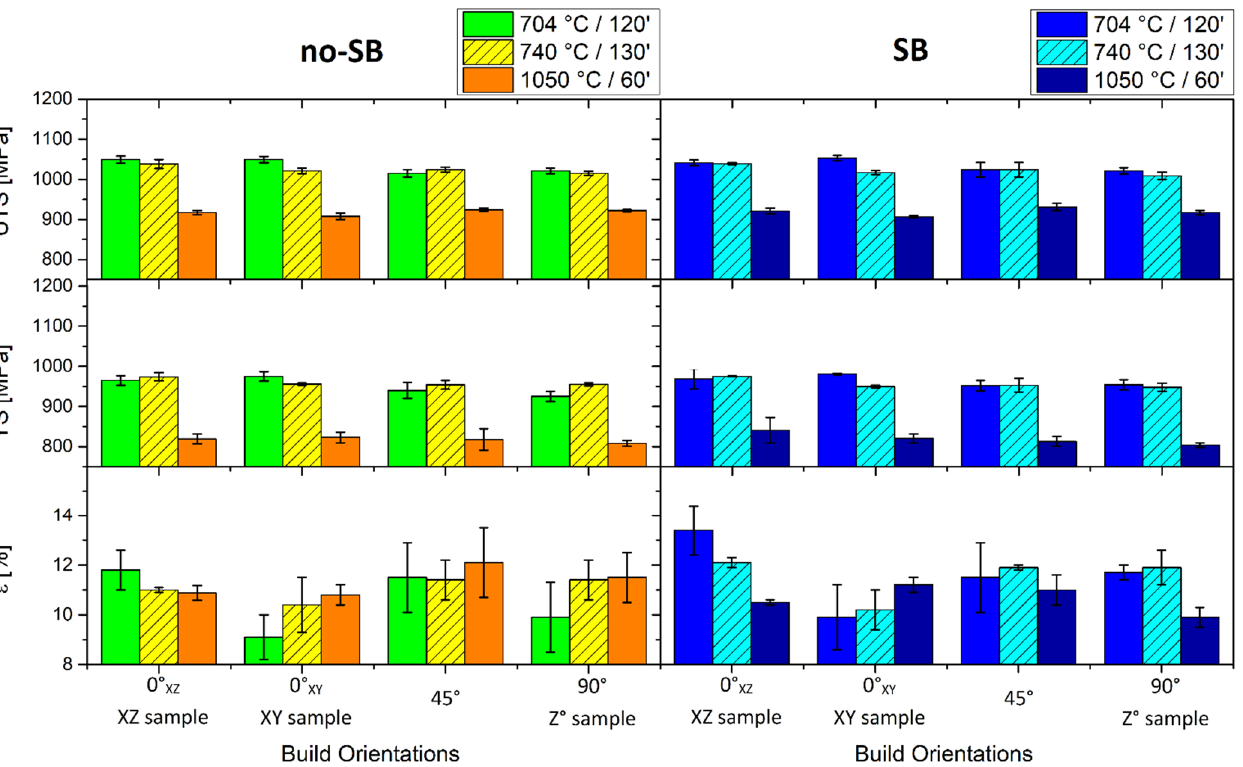
Figure 11. Mechanical properties of 0° XZ -, 0° XY -, 45°-, 90° Z -samples heat-treated at 704 °C/120 ′ , 740 °C/130 ′ and 1050 °C/60 ′ in no-SB ( right section ) and SB ( left section ) conditions. Table 4. Average values of the mechanical properties of no-SB and SB samples heat-treated at 704 °C/120 ′ , 740 °C/130 ′ and 1050 °C/60 ′ .